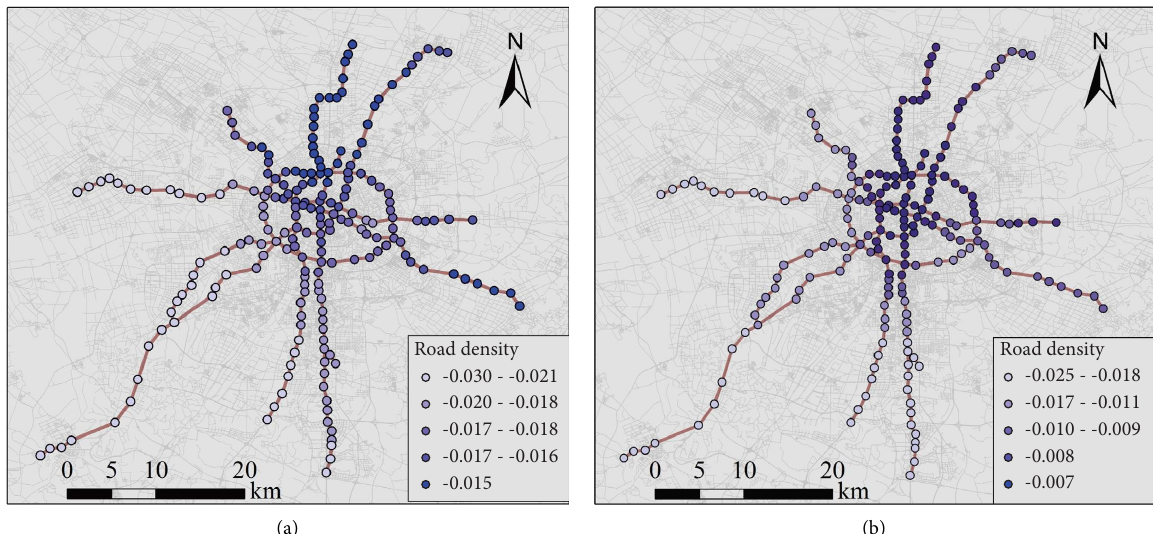
Figure 8: Spatially varying efects of road density on the access/egress distance. (a) Efects of road density on the access distance and (b) efects of road density on the egress distance.